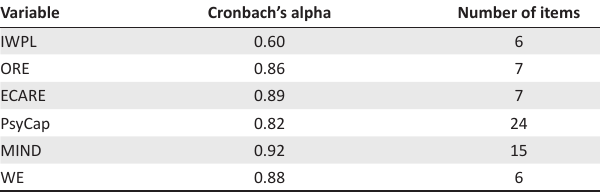
TABLE 1: Reliability estimates.